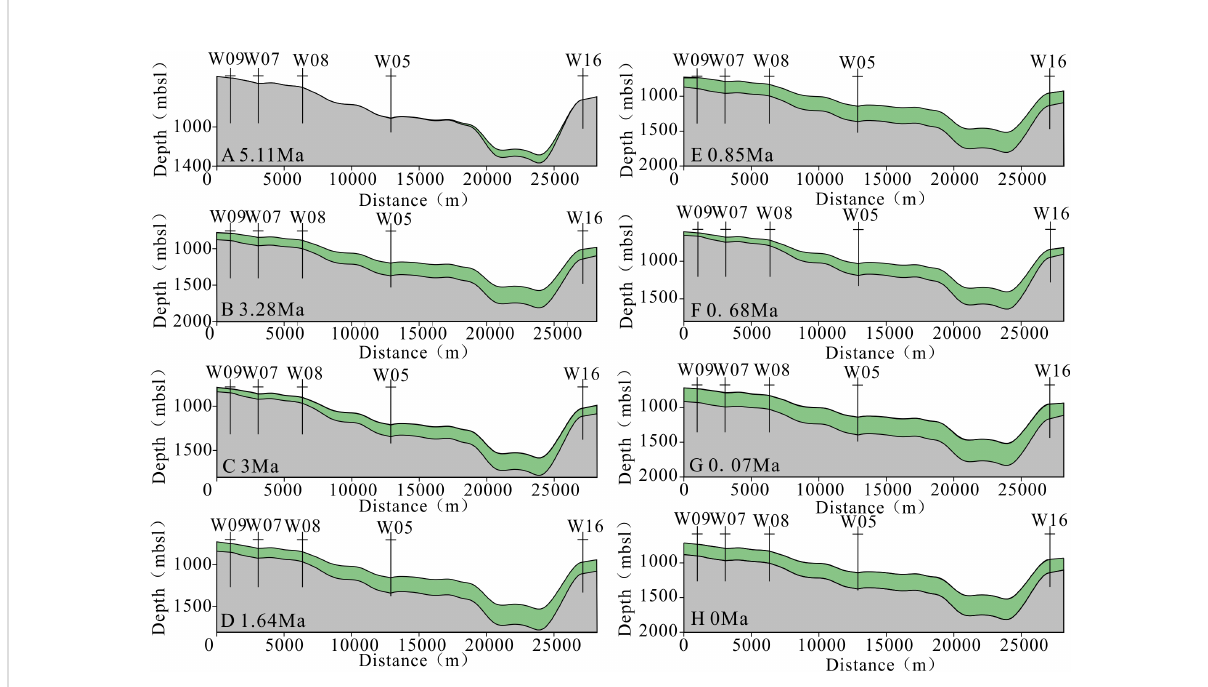
FIGURE 6 Characteristics of the GHSZ in the 2D pro fi le. (A) 5.11 Ma, (B) 3.28 Ma, (C) 3 Ma, (D) 1.64 Ma, (E) 0.85 Ma, (F) 0.68 Ma, (G) 0.07 Ma, (H) 0